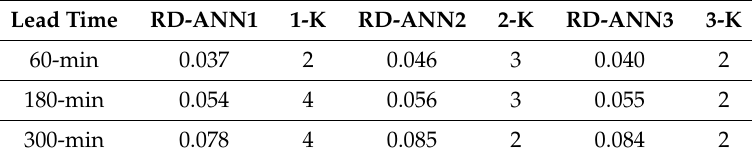
Table 2. Sensitivity study to determine optimal RD-ANN configuration. The mean absolute error (MAE) is listed for each of the RD-ANN subsets where 1 indicates the surface observation subset, 2 indicates the DICast ® forecasts subset, and 3 indicates the clearness index subset. The optimal choice of the number of regimes, K, is shown for each subset. Lead Time RD-ANN1